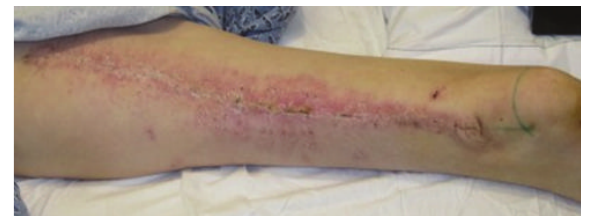
Figure 4: One month postoperative